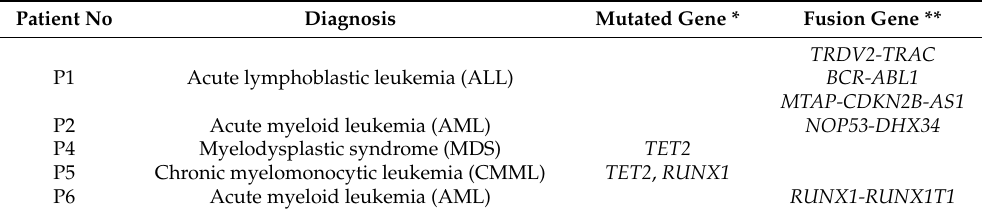
Table 1. List of mutations and fusion genes characteristic for leukemias detected in patient’s genomes.